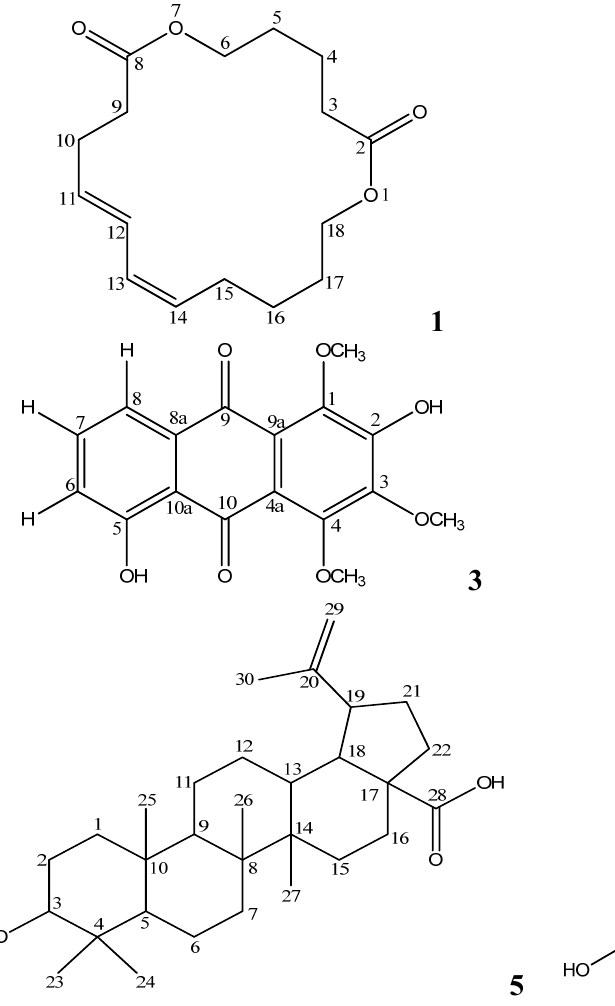
Figure 1. Structures of